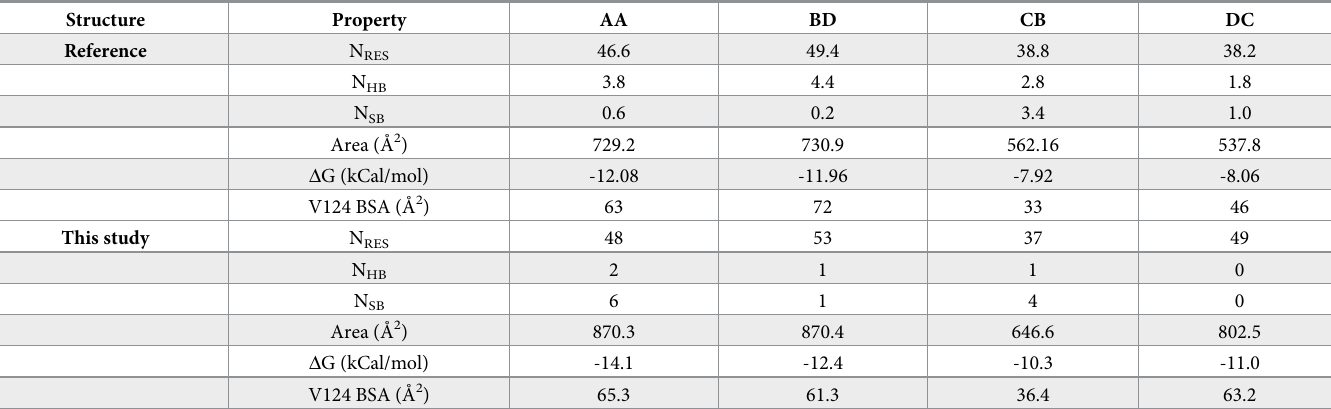
Table 3. PISA inter-dimer interface analysis of T = 4 capsids 1 .